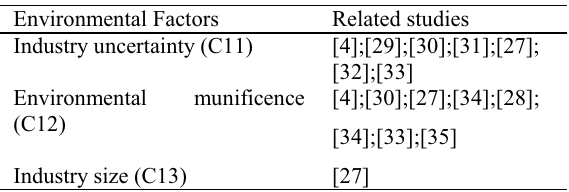
Table 1: Environmental factors (cid:43)(cid:68)(cid:87)(cid:68)(cid:4)(cid:3)(cid:37)(cid:68)(cid:250)(cid:89)(cid:88)(cid:85)(cid:88)(cid:3)(cid:78)(cid:68)(cid:92)(cid:81)(cid:68)(cid:247)(cid:213)(cid:3)